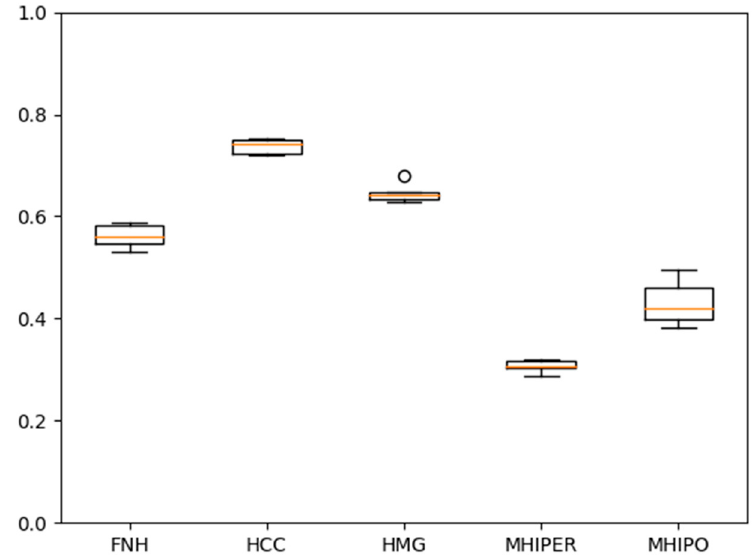
Table 5. Average test accuracy [%] and the corresponding standard deviation. Unbalanced number of examples per class. Model/Patients